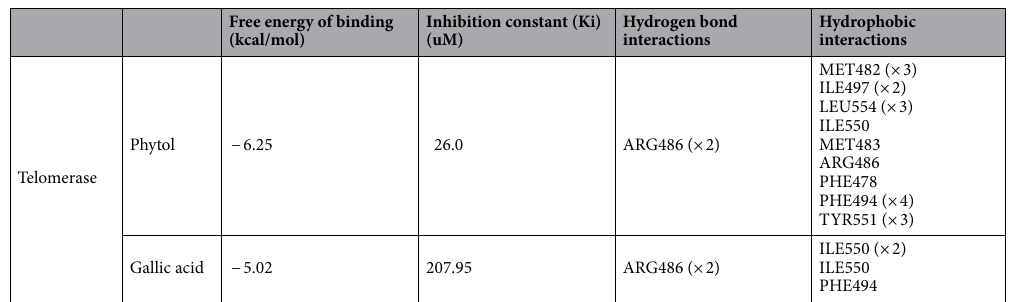
Table 4. Binding affinities and potential molecular interactions of gallic acid and phytol with telomerase.